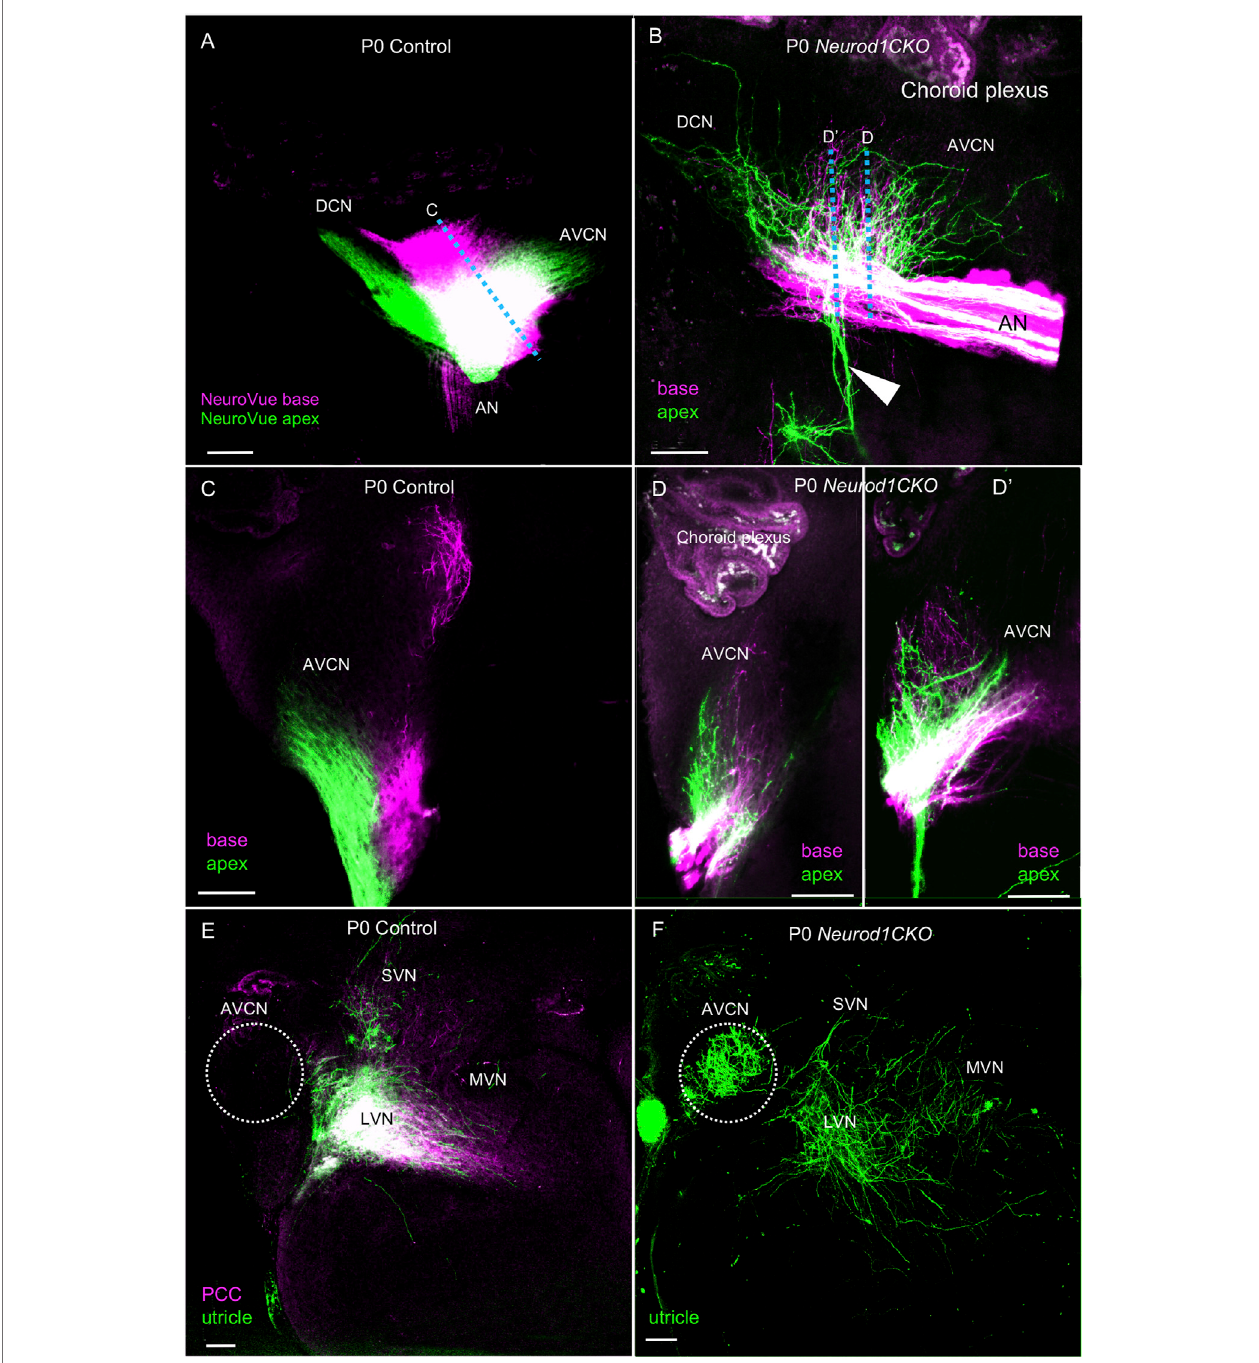
FIGURE 8 | Disorganized central projections of Neurod1CKO inner ear neurons show aberrant interconnections between the auditory and vestibular systems. (A , B) Lipophilic differently colored NeuroVue dyes were applied tothe apex and basetolabelcochlear afferents. In thelateral viewofthecochlear nucleus ofthecontrol, dye tracing shows the normal segregated basal and apical cochlear afferents of the auditory nerve and segregated projections to the AVCN and DCN. In contrast, reduced, disorganized, and overlapping central projections are shown in the cochlear nucleus of Neurod1CKO mice. Note unusual fi bers from the apex projecting away from the cochlear nucleus and auditory nerve (arrowhead). (C) Coronal sections of control show the segregation of basal and apical afferents. (D , D ’ ) Sections of Neurod1CKO showanoverlapofdisorganized fi bersfromtheapexandbase.Dottedlinesincorresponding fi guresindicatethesectionplanesin (A , B) . (E , F) Dyetracing from the utricle and theposterior canal crista (PCC) shows vestibular afferents innervatingthe lateral, medial, and superiorvestibular nucleithat areimmediatelyadjacent to the AVCN in the control mice. A single dye tracing from the utricle shows vestibular afferents reach vestibular nuclei and form a profound projection to the AVCN in Neurod1CKO mice. The area of the AVCN is indicated by dotted circle. Scale bars: 100 µm. AN, auditory nerve; AVCN, anteroventral cochlear nucleus; DCN, dorsal cochlear nucleus; LVN, MVN, SVN, lateral, medial, and superior vestibular nuclei; VN, vestibular nerve.